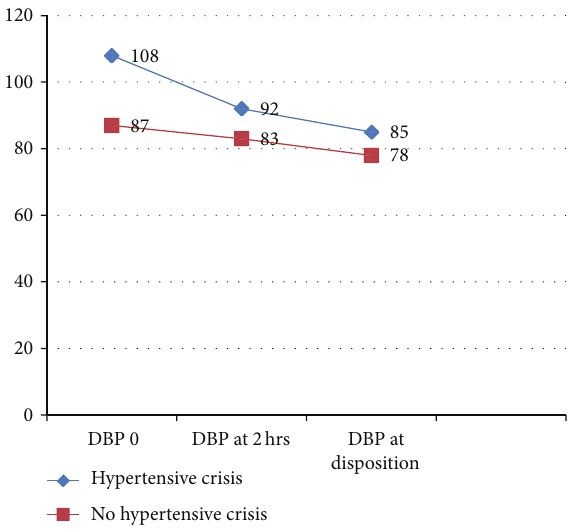
Figure 2: Trend of diastolic blood pressure in